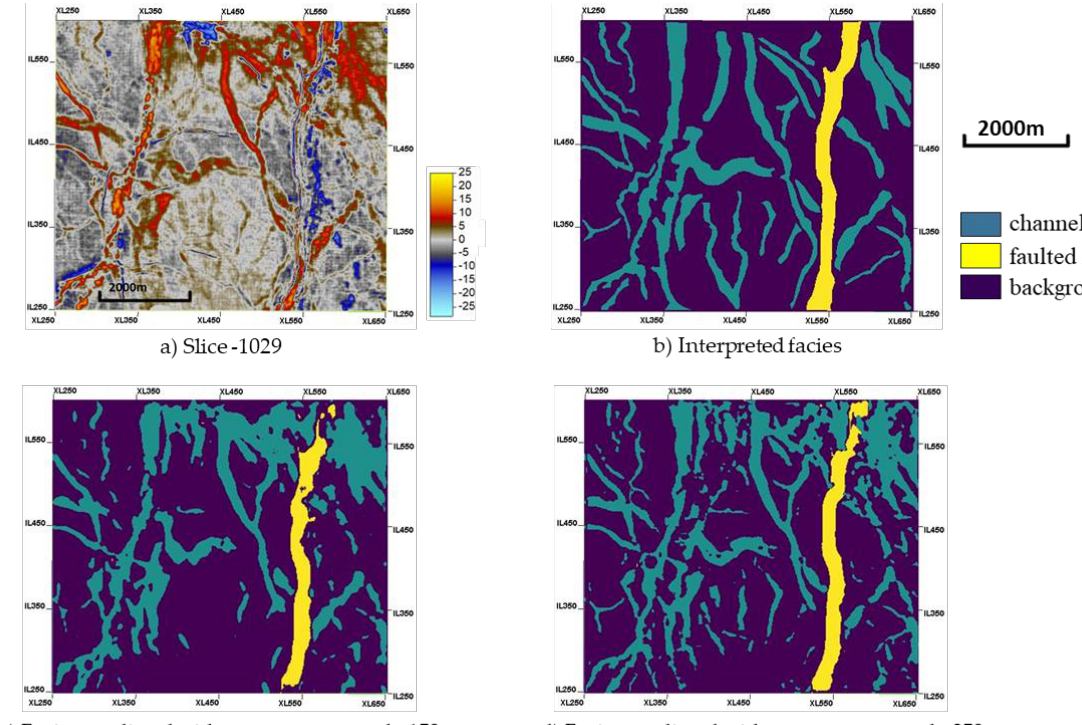
Figure 26. Seismic slice ( a ) and its interpretation ( b ) and examples of prediction obtained with U-Net with different hyperparameter sets ( c ) and ( d ). The prediction in ( d ) is much more detailed than the one in ( c ), even some details not present in the manual interpretation were captured.